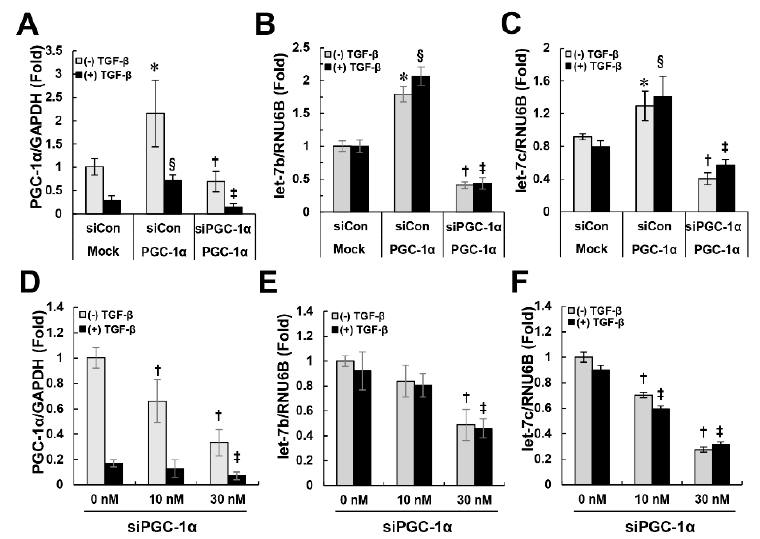
Figure 6. Regulation of let-7b/c by PGC-1 α . To examine the regulation of let-7b/c by PGC-1 α , control siRNA- or PGC-1 α siRNA-transfected mock and PGC-1 α cells ( A–C ) and PGC-1 α siRNA-transfected HK-2 cells ( D–F ) were prepared as described in the Materials and Methods section. The levels of let-7b, let-7c (target miRNA) and RUN6B (internal reference) were quantitatively analyzed by real-time PCR. The bar graph shows the relative ratio of let-7b or let-7c to RUN6B, with the value in untreated mock cells set to 1. * p < 0.05, untreated mock cells vs. PGC-1 α cells; § p < 0.05, TGF- β -treated mock cells vs. PGC-1 α cells; † p < 0.05, siCon vs. siPGC-1 α treatment of untreated PGC-1 α cells; ‡ p < 0.05, siCon vs. siPGC-1 α treatment of TGF- β -treated PGC-1 α cells.